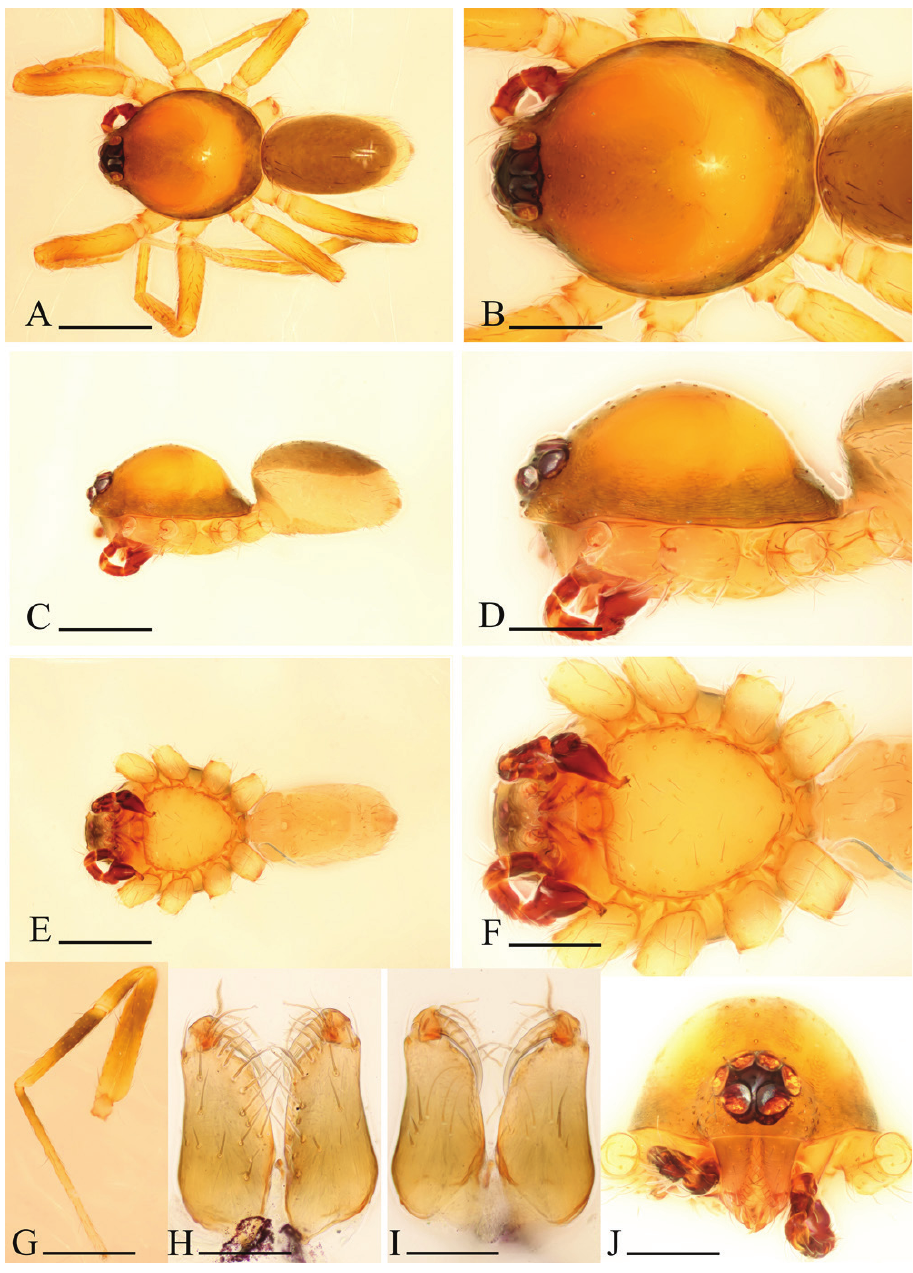
Figure 4. Ischnothyreus brunneus sp. n., male. A, C, E habitus, dorsal, lateral and ventral views B, D, F, J prosoma, dorsal, lateral, ventral and anterior views G, left leg IV, retrolateral view H, I cheli- cerae, anterior and posterior views. Scale bars: A, C, E, G = 0.4 mm; B, D, F, J = 0.2 mm; H, I = 0.1